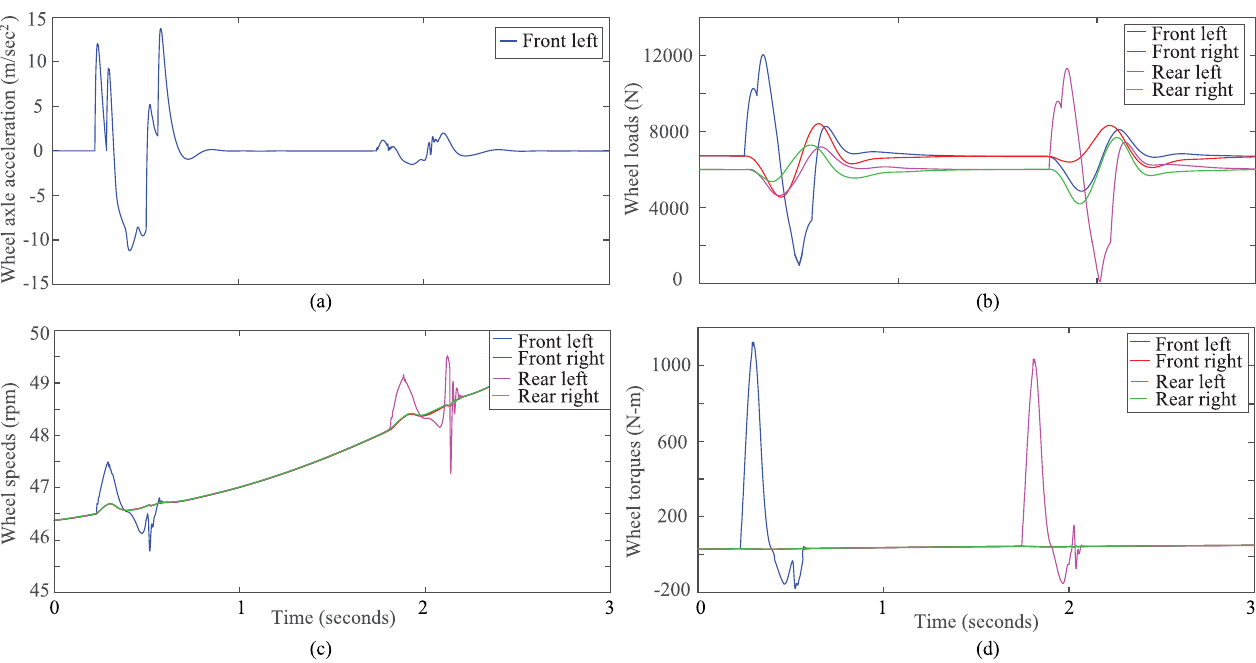
Fig. 17. Simulation results: (a) front-left axle acceleration; (b) wheel normal loads; (c) wheel speeds; (d) wheel torques.